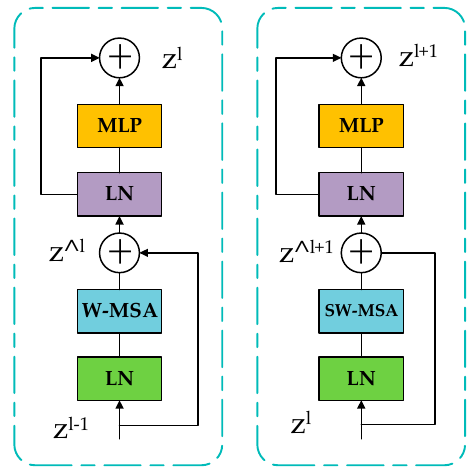
Figure 3. Swin Transformer’s backbone network.